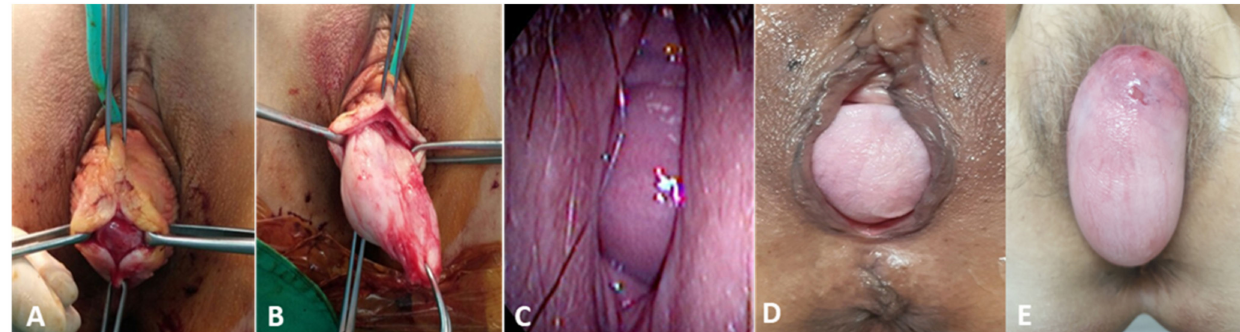
Figure 1. Conditions mimicking pelvic organ prolapse (POP) and true POP. ( A , B ) anterior vaginal wall leiomyoma mimicking anterior compartment POP. ( C ) Urethral diverticulum mimicking anterior compartment POP. ( D ) Rectocele and ( E ) enterocele revealed by translabial